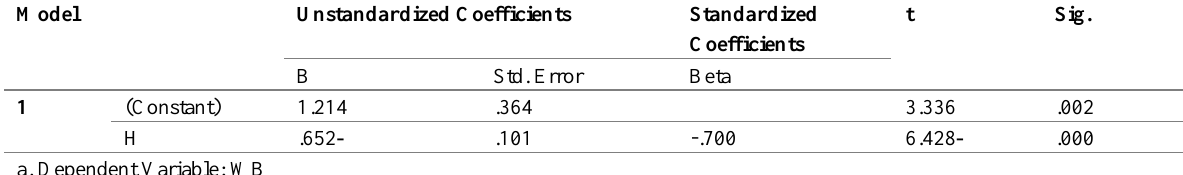
Table 13: Results of Linear Regression between Hope and Workplace Bullying